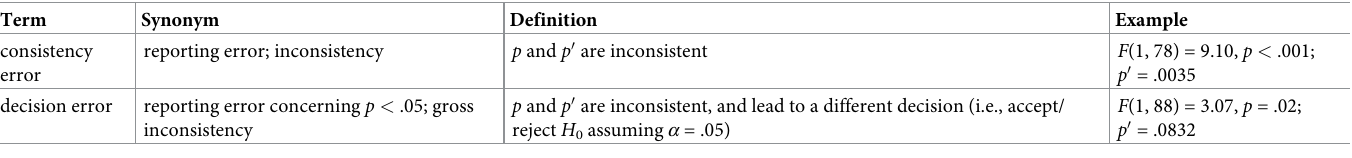
Table 1. Definitions and